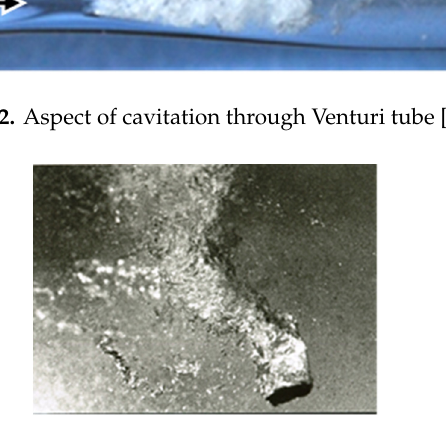
Figure 3. Aspect of vortex cavitation arising downstream of a butterfly valve [48].